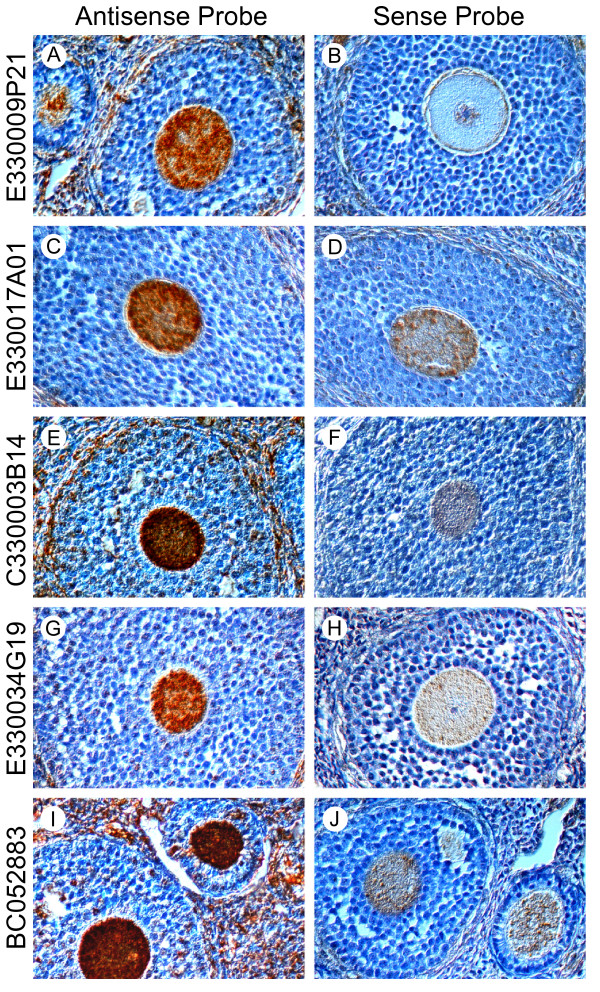
In situ hybridization. In situ hybridization of the five functionally un-annotated genes potentially up-regulated by FIGLA. Paraformaldehyde fixed and paraffin embedded adult ovarian section were hybridized with digoxigenin (DIG) labeled antisense (A, C, E, G, I) or sense (B, D, F, H, J) synthetic oligonuclotides probes specific to [E330009P21Rik] (A, B), [E330017A01Rik] (C, D), [C330003B14Rik] (E, F), [E330034G19Rik] (G, H) and [Genbank:BC052883] (I, J) cDNAs.